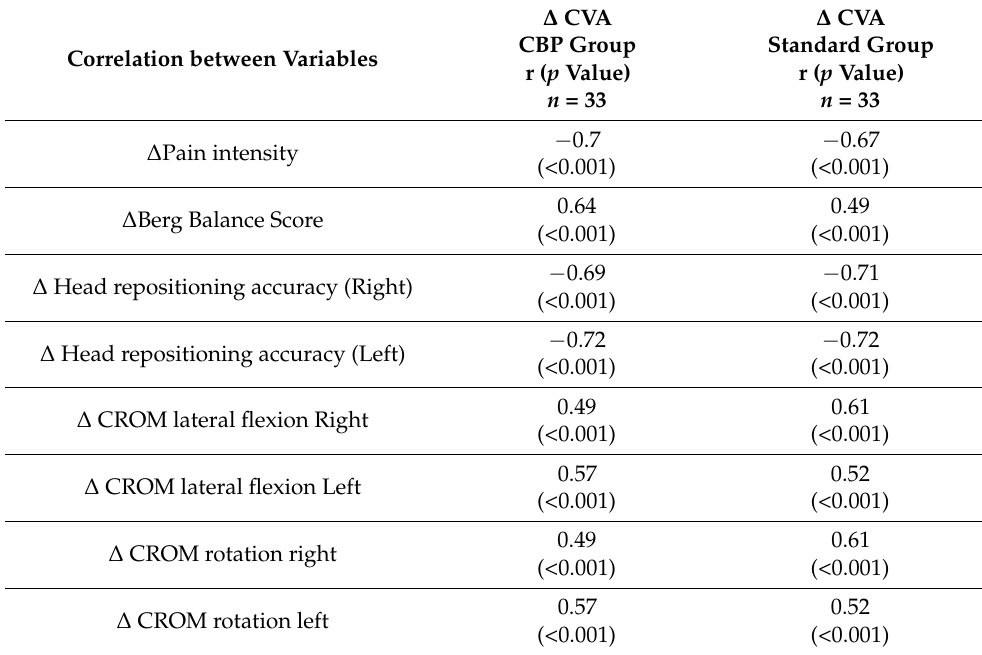
Table 5. Correlations (Pearson’s r ) between the amount of change in CVA angle and the amount of change of all measured outcomes (3-month follow-up scores and initial scores).